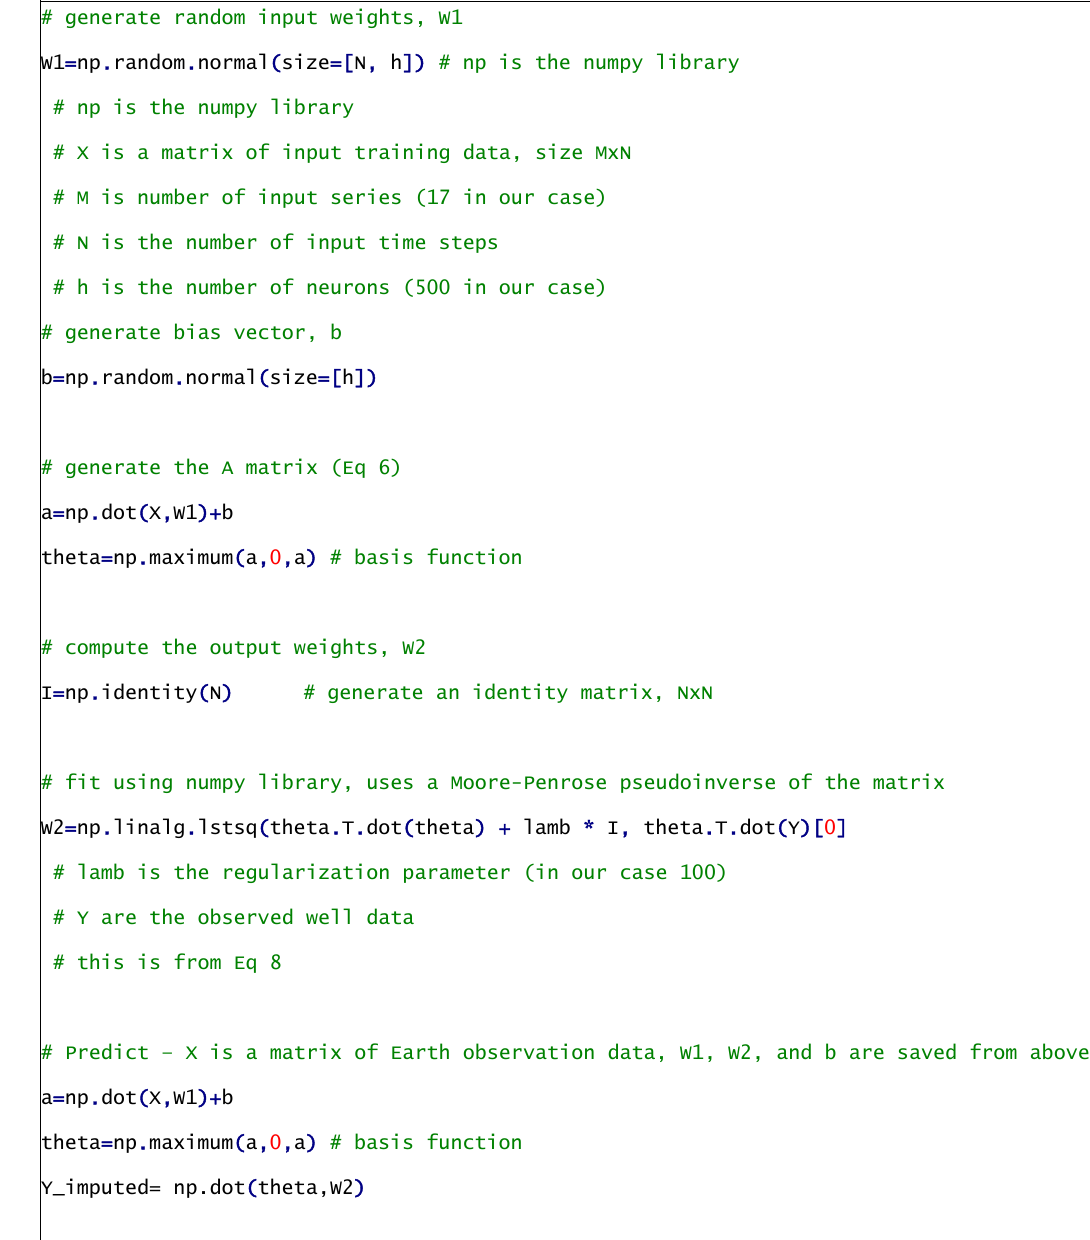
Figure 4. Pseudo code for Extreme Learning Machine (ELM) imputation following python syntax, where X is a matrix of Earth observation data, Y is a vector of training data, W1 , theta , and W2 are variables, X1 is a matrix of each observation data over the imputation target period, and Y_imputed are the unscaled imputed data. X , X1 , and Y are scaled to the limits of the training data, Y_imputed needs to be re-scaled to obtain actual values.